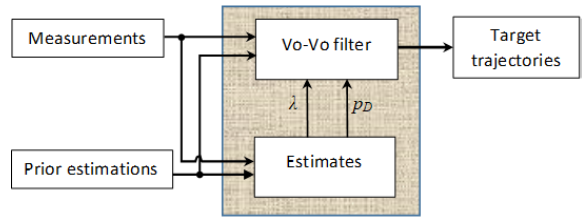
Figure 1. The proposed structure of the B -GLMB